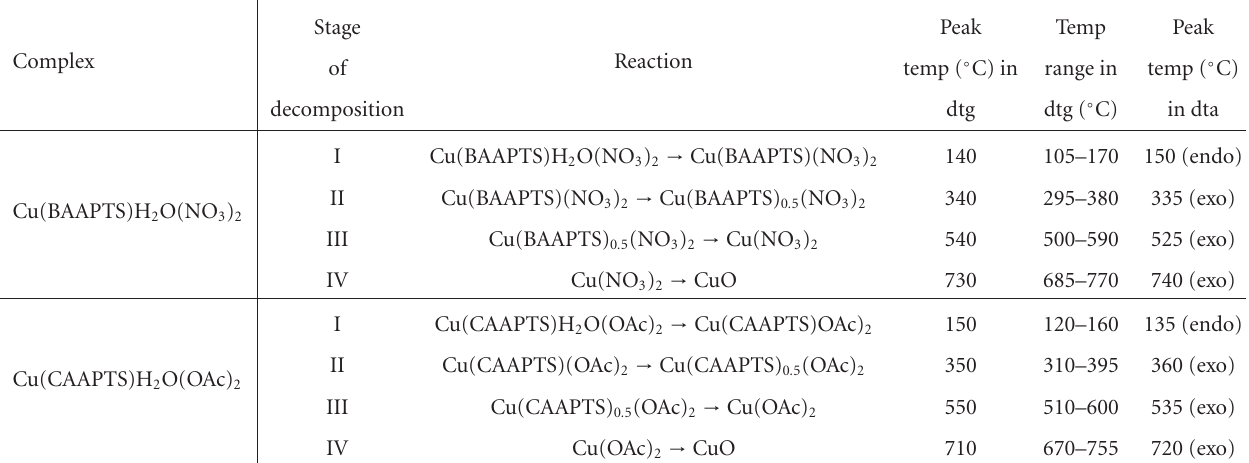
Table 6: Thermal decomposition data for Cu 2+ complexes of BAAPTS and